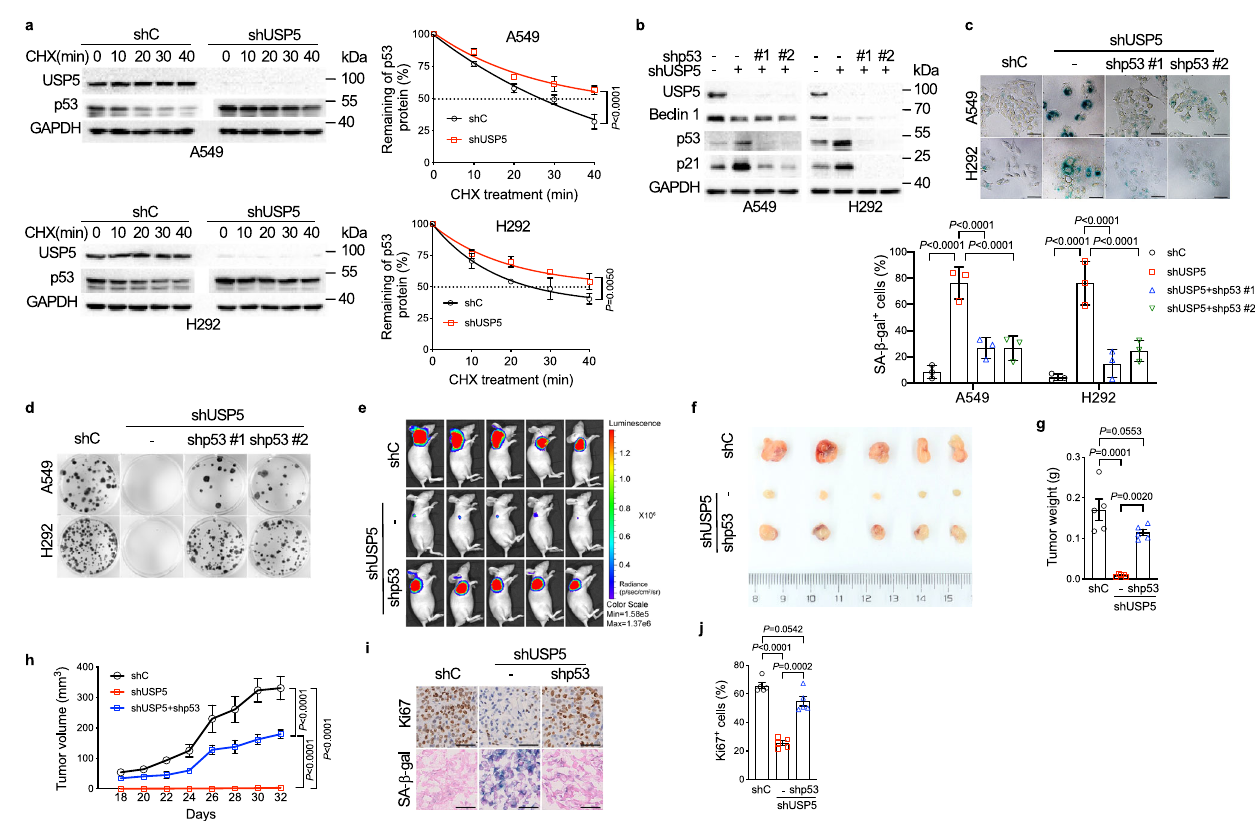
Fig.3|Ablationof USP5 leadstostabilizationofp53resultinginsenescenceand suppression of tumor growth in vivo. a A549 or H292 cells stably expressing shUSP5 or control shRNA (shC) were treated with 50 μ g/mL CHX for the indicated timeintervalsbeforecollection.Theproteinhalf-lifeplotswereshown. b – d A549or H292 cells stably expressing shUSP5 were infected with lentiviral-shp53 (#1 or #2 ) or controlshRNA(shC)followedby westernblot analyses( b ),SA- β -galstaining ( c ), or colony formation assays ( d ).Scale bar=50 μ m. e – j A549-Antares2 cells (2×10 6 ) stably expressing shUSP5 and shUSP5+shp53 were subcutaneously transplanted